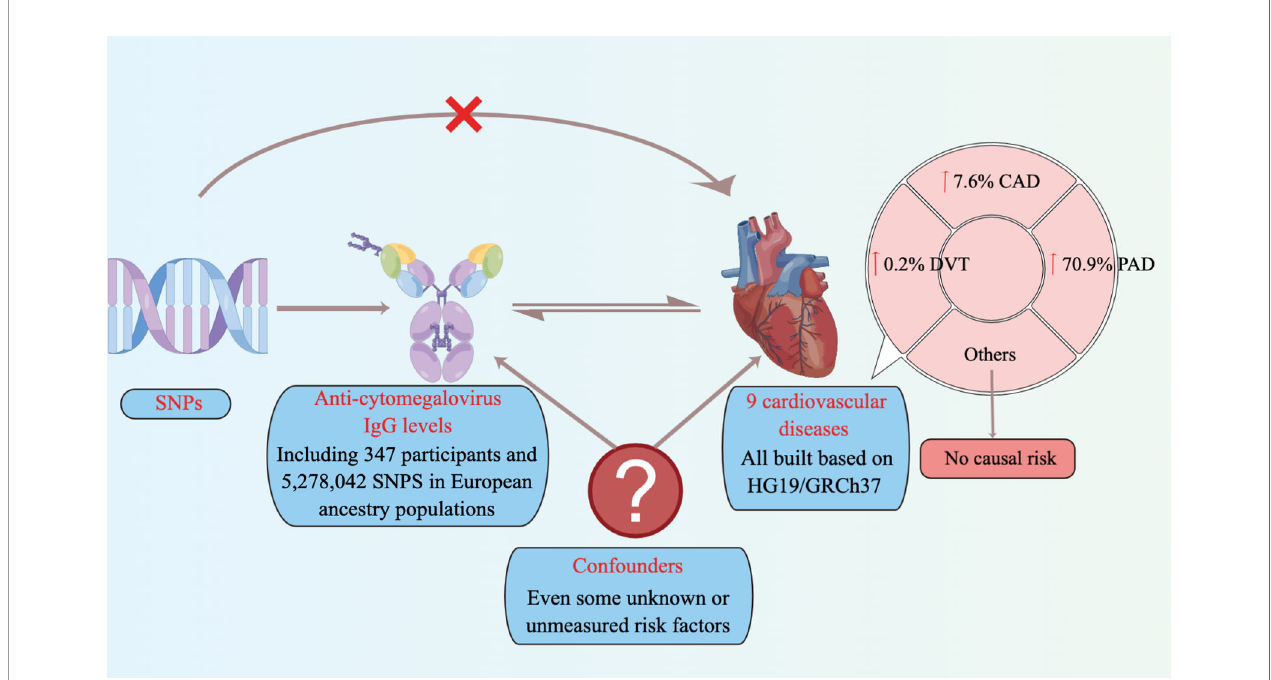
FIGURE 1 | Schematic representation of an MR analysis. We selected SNPs associated with anti-cytomegalovirus IgG levels, and the corresponding effect for these SNPs was estimated based on the risk of 9 cardiovascular diseases. Because of the randomization and independence of alleles at meiosis, MR is a powerfully predictive tool to assess causal relationships with no bias inherent to observational study designs. CAD, coronary artery disease; PAD, Peripheral artery disease; DVT, deep vein thrombosis; MR, Mendelian randomization; SNPs, single-nucleotide